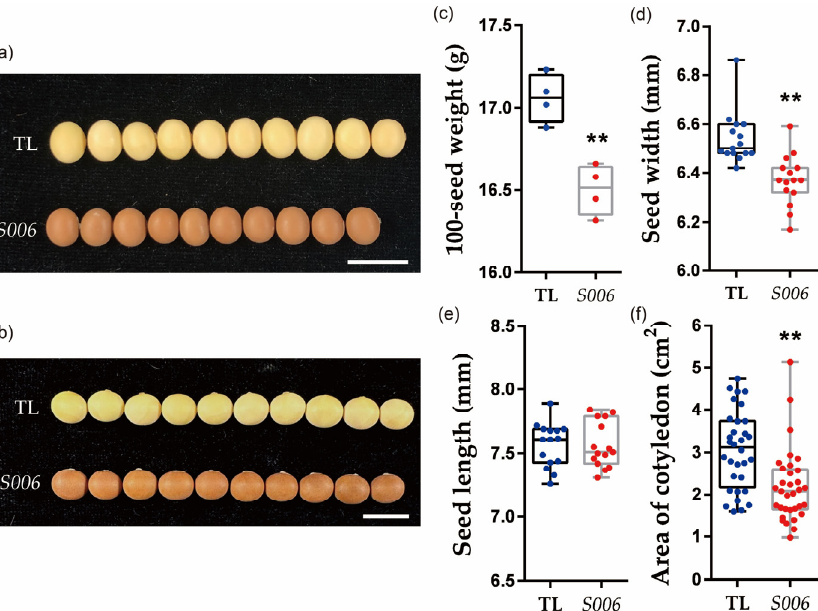
Figure 1. Comparative analysis of phenotypes between S006 mutant and wild-type seeds. ( a ) Image of seeds showing decreases in width in S006 mutant (10 seeds are shown in each case); ( b ) image of seeds showing no significant changes in length in S006 mutant; ( c ) 100-seed weight was signifi- cantly decreased in S006 mutant; ( d ) seed width significantly decreased in S006 mutant.; ( e ) there was no significant difference in seed length between S006 mutant and wild type; ( f ) cotyledon area significantly decreased in S006 mutant. Asterisks indicate a significant difference according to Student’s t -test (**, p < 0.01).